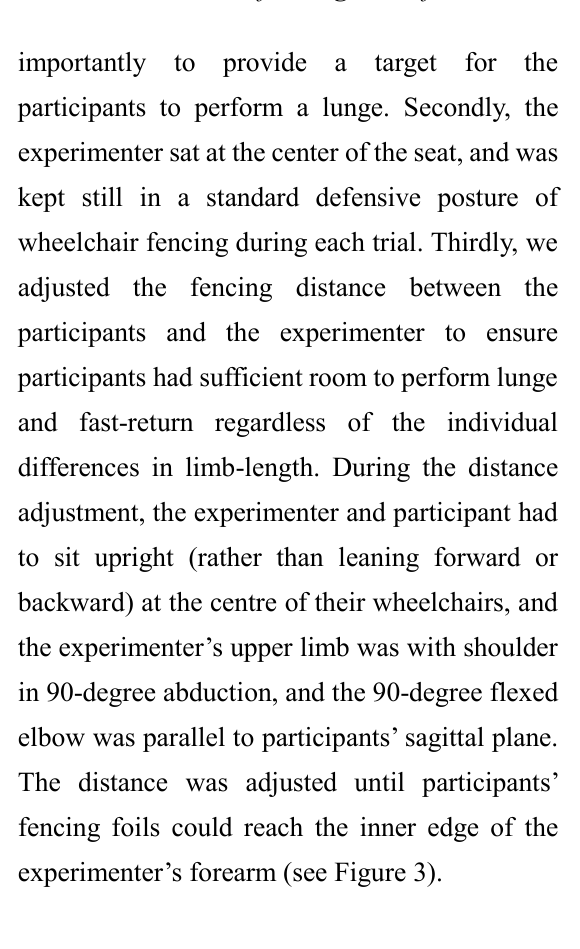
Demographic information Fencer Code